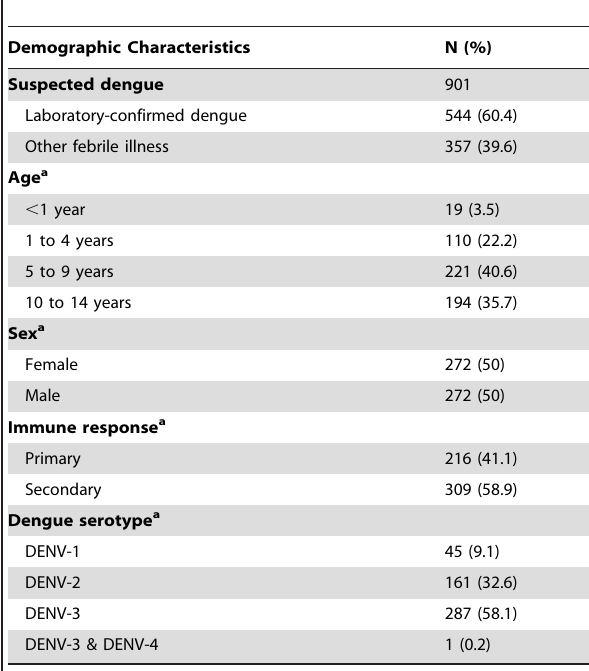
Table 2. Demographic characteristics of study population,